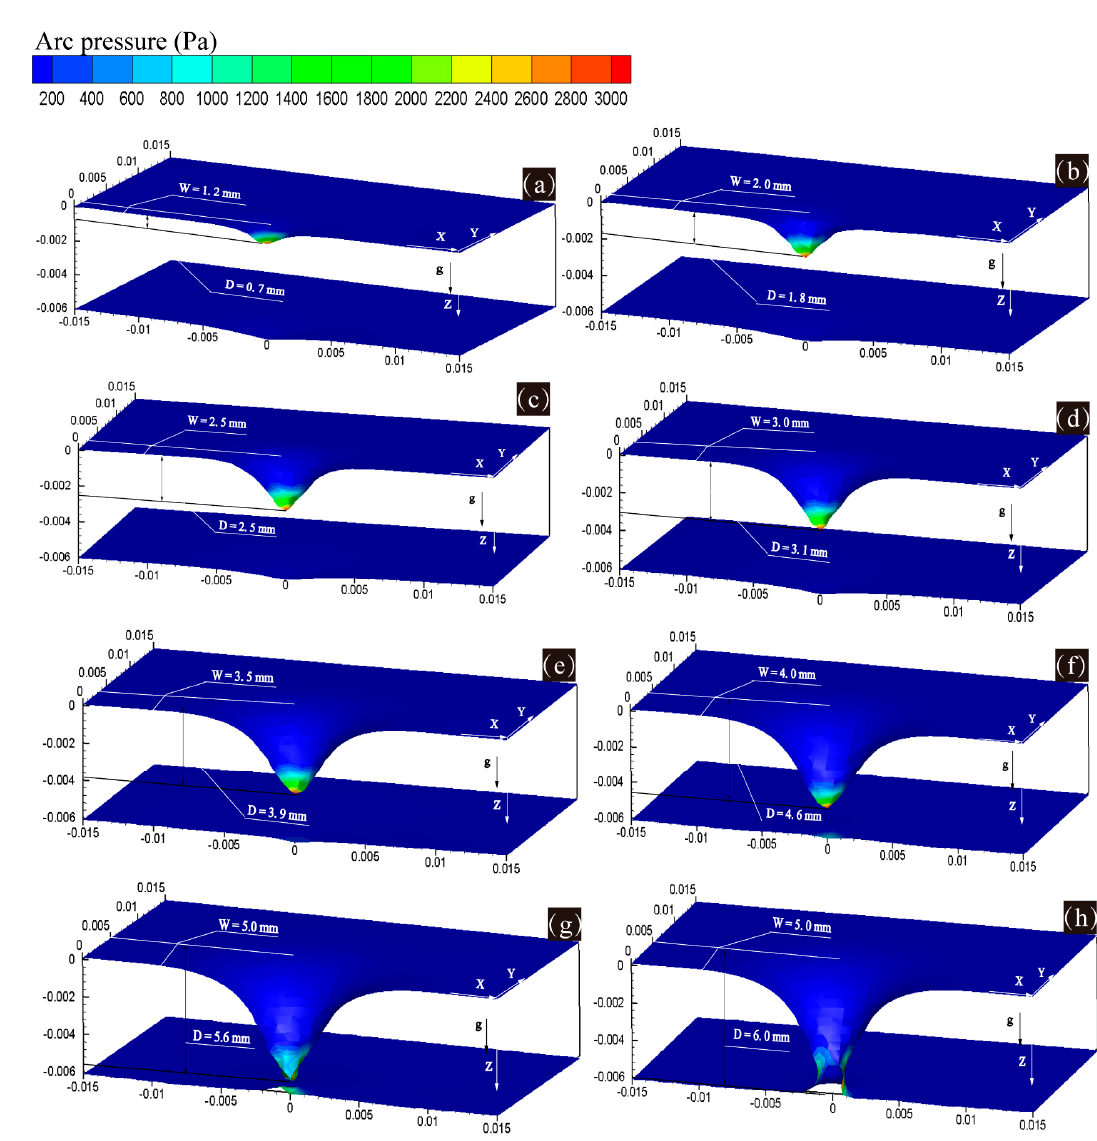
Figure 7. Dynamic evolution of keyhole size and arc pressure distribution on the keyhole surface of case a ( a ) 1.72 s, ( b ) 2.43 s, ( c ) 2.87 s, ( d ) 3.32 s, ( e ) 3.65 s, ( f ) 3.92 s, ( g ) 4.34 s, ( h ) 4.55 s.